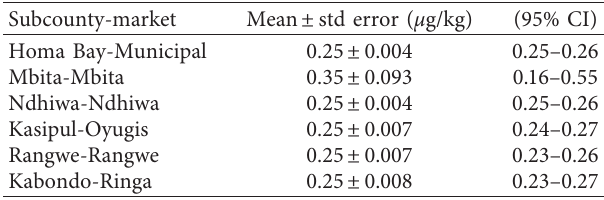
Table 5: Mean aflatoxin content in the